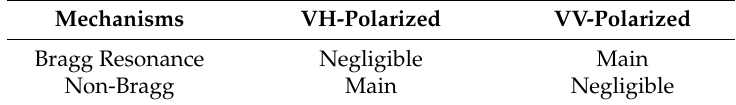
Table 2. The roles of the two mechanisms with respect to the VH and VV